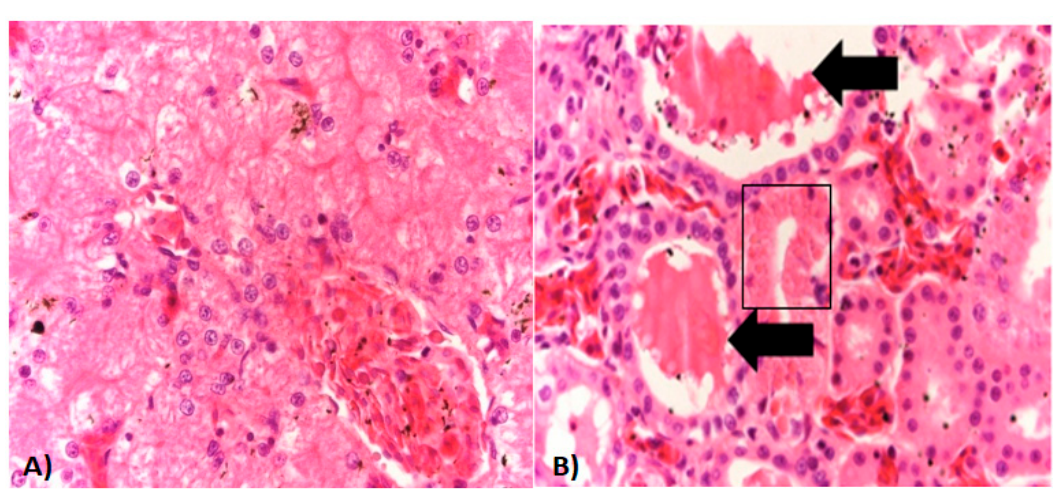
Figure 2. Macroscopic lesions of ranavirus-infected bullfrogs. ( A ) Extensive ulceration of the forelimb.